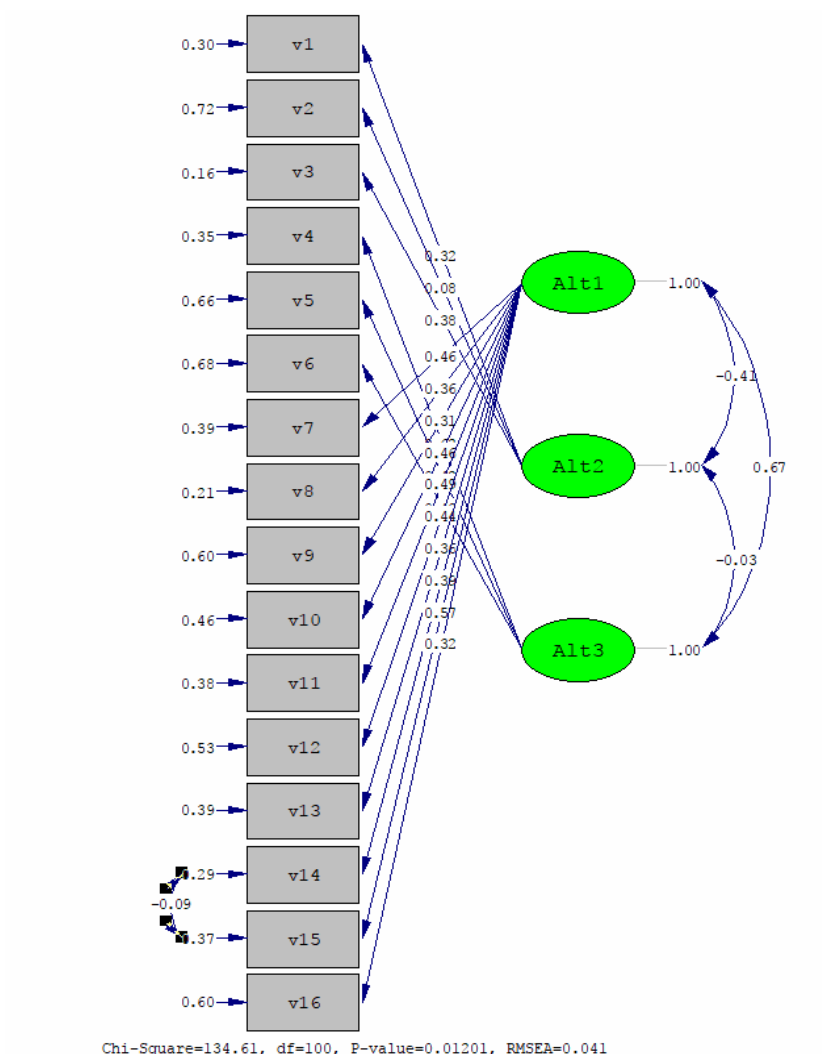
Figure 2- Path diagram of the four-dimensional model after modification Reliability of the Scale in